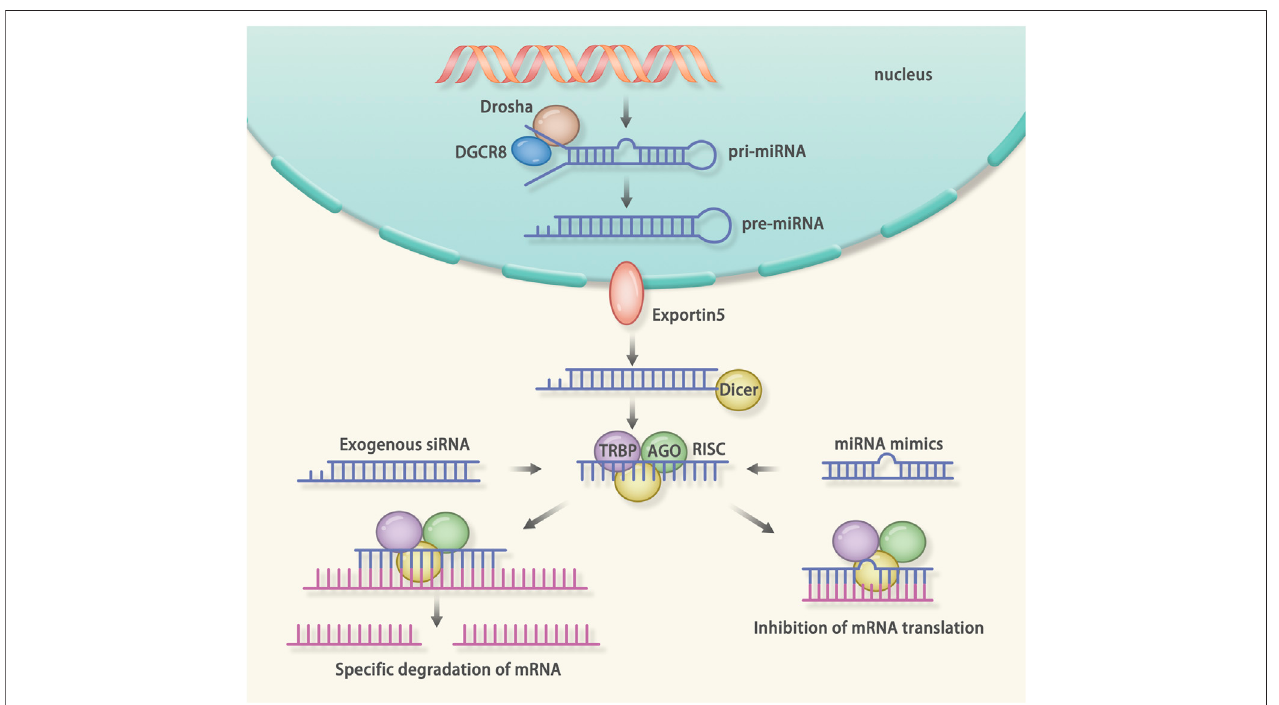
FIGURE 5 | Mechanism of RNA interference (RNAi): RNAi is a post-transcriptional gene silencing method. The microRNA (miRNA) and small interfering RNA (siRNA) can mediate the RNAi. The miRNA is a kind of endogenous non-coding RNA. The miRNA-mediated RNAi starts from the generation of the pri-miRNA. When generated endogenously, the pri-miRNA is cut by the drosha and DGCR8, resulting in the formation of the pre-miRNA. After that, the pre-miRNA is transported into the cytoplasm. Dicer recognizes the pre-miRNA and cuts it into a single strand. Finally, the transactivation response element RNA-binding protein (TRBP), Dicer, Argonauteprotein,andthemiRNAformtheRNAinducedsilencingcomplex(RISC).TheRISCwillbindthecomplementarymRNAtoinhibitthetranslation.ThesiRNAisa kind of exogenous non-coding RNA. After delivered into the cells, the siRNA will be cleaved into a single strand RNA. After that, the TRBP, Dicer, Argonaute protein and the siRNA form the RISC. The RISC will degrade the complementary